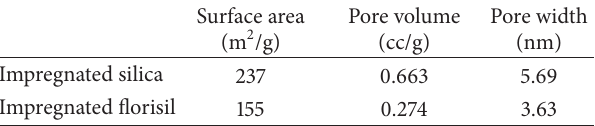
Table 1: BET analysis summary of impregnated silica and